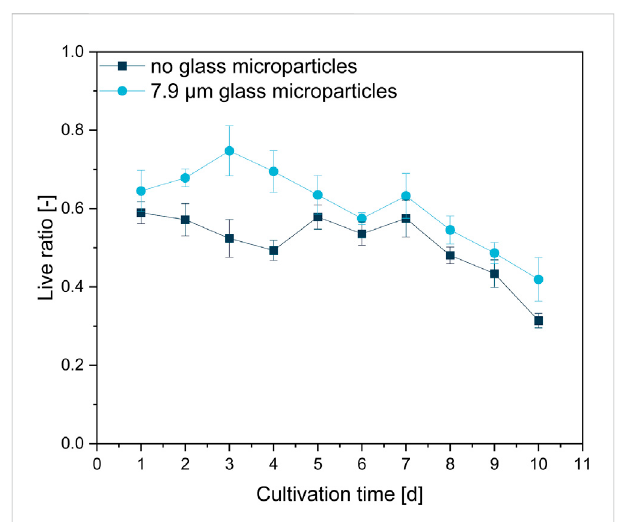
FIGURE 8 Live ratio calculated with Eq. 2 of fl uorescently stained pellet slicesoriginatingfromunsupplementedcontrolcultivationandaglass microparticle supplemented MPEC (10 g · L − 1 , x 50 = 7.9 µm) cultivation of L. aerocolonigenes